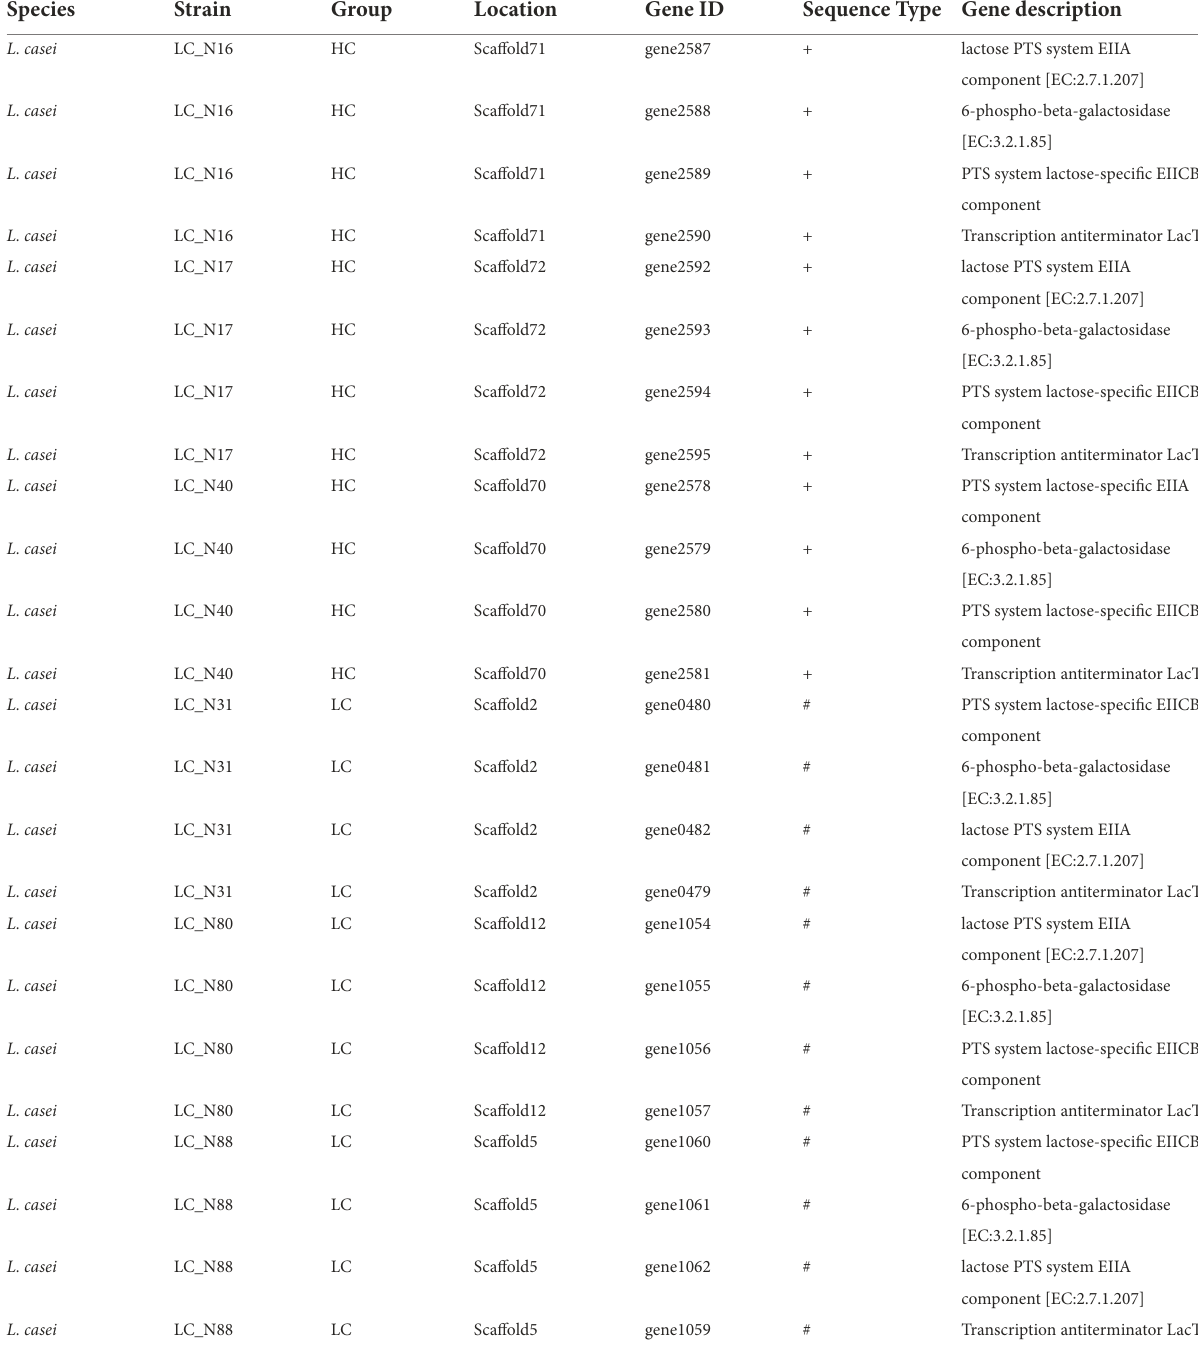
TABLE 2 Location of lac operon in exemplar L. casei strains from the high acid (HC) and low acid (LC) groups. Species Strain Group Location Gene ID Sequence Type Gene description